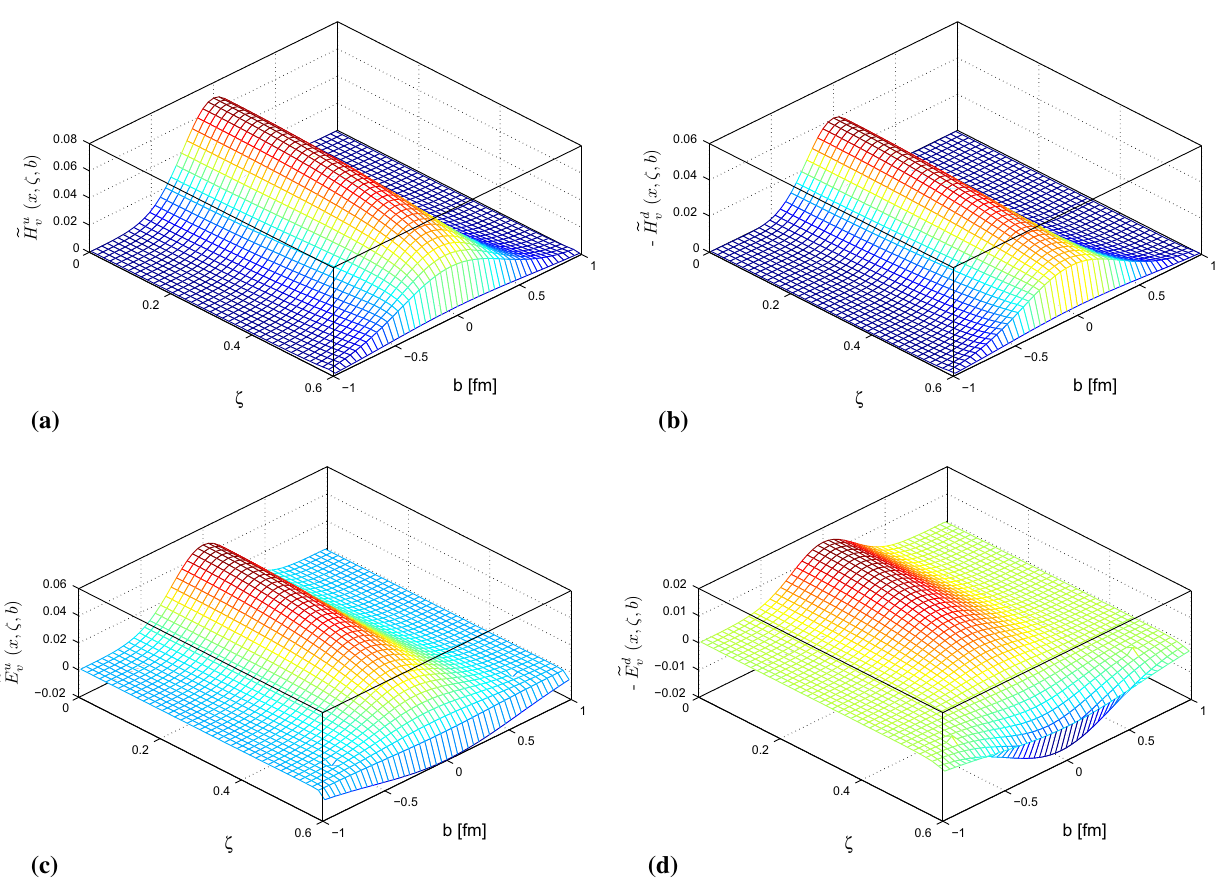
Fig. 7 (Color online) Plots of helicity-dependent GPDs for the nonzero skewness in impact space vs. ζ and b = | b | for a fixed value of x = 0 . 6. The left panel is for the u quark and the right panel is for the d quark